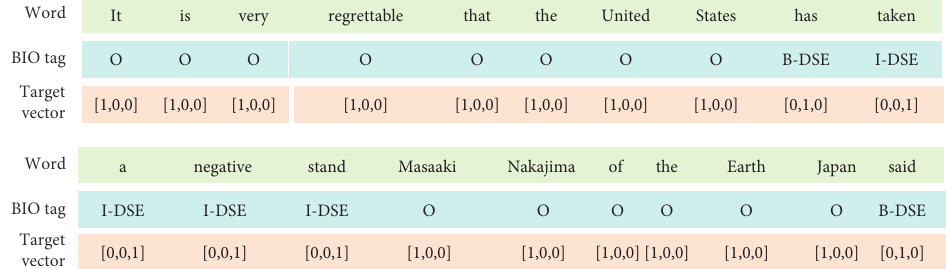
Figure 3: Illustration of conversion from word to target vector.